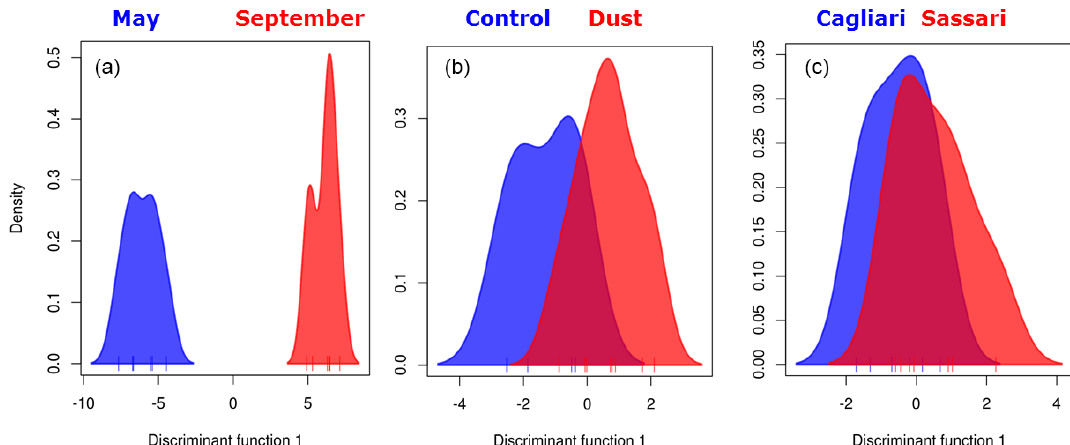
Figure 5. Discriminant analysis of principal components analysis. Group partitioning involved (a) sampling month, (b) ongoing meteoro- logical event, and (c) sampling